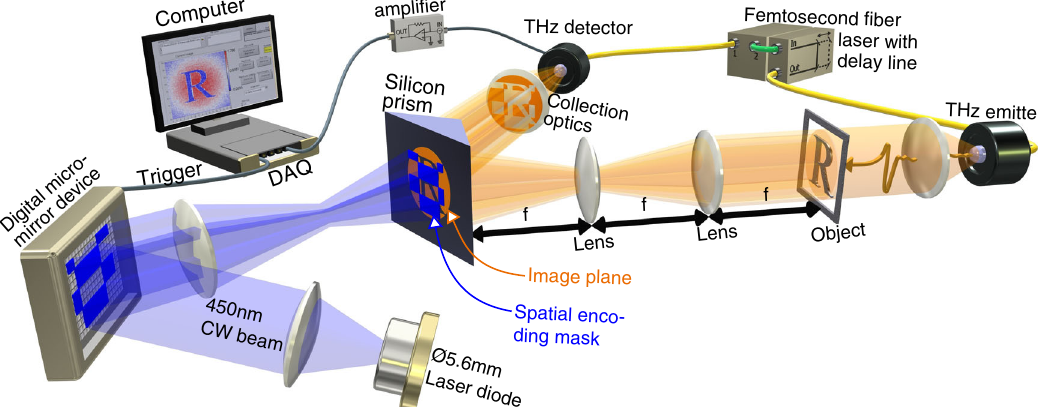
Fig. 2 Experimental illustration. A collimated THz pulse is launched at an object, an image of the object is projected onto the top interface of a silicon prism with the THz incident angle being 30°. Simultaneously, this top interface has a 2D conductive pattern imprinted onto to it via the photoexcitation of a 450 nm continuous-wave light beam, which itself has been spatially patterned by a DMD, thereby imparting a 2D encoding mask onto the THz beam. The re fl ected THz is collected onto a single-pixel photoconductive THz antenna and detected signals for many different encoding masks are recorded. Note, many of the visible-light projection optics have been left out for visual